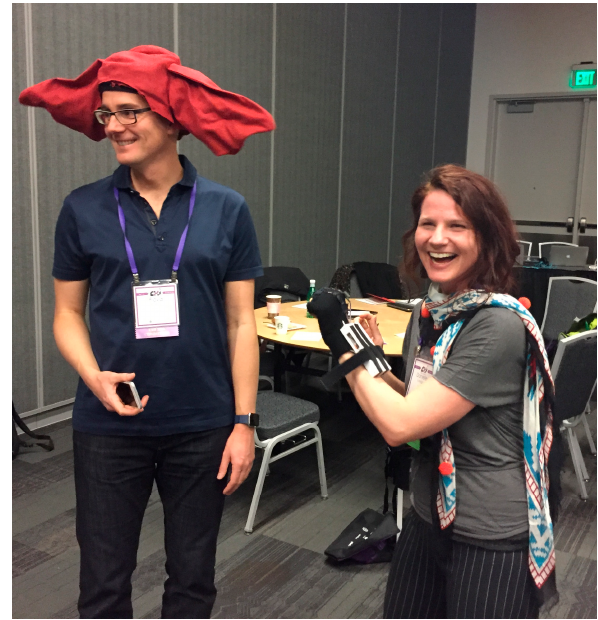
Figure 5. Engaging with the Ears.